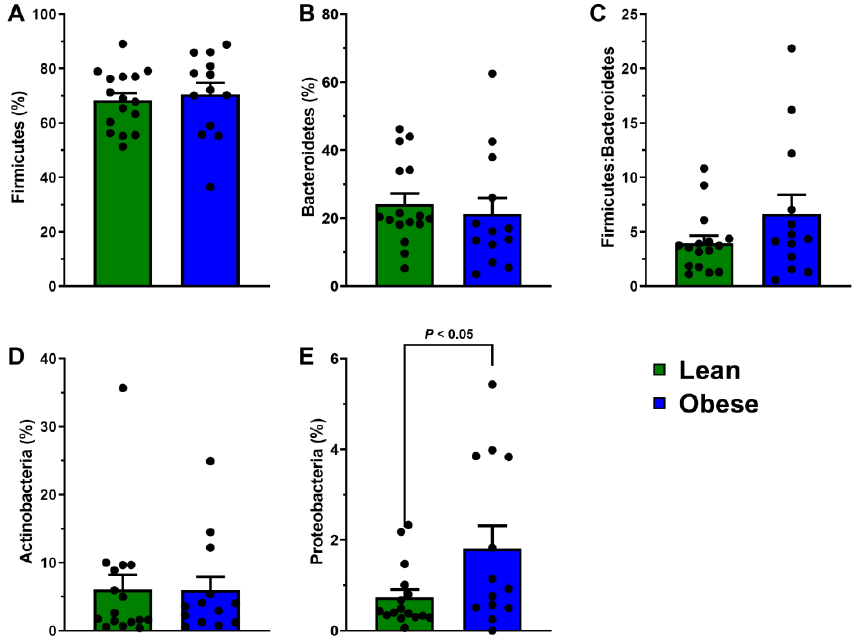
Figure 4. Phyla-level abundances of gut microbiota in obese and lean individuals. ( A ) Firmicutes, ( B ) Bacteroidetes, ( C ) Firmicutes:Bacteroidetes ratio, ( D ) Actinobacteria, and ( E ) Proteobacteria between obese and lean individuals. Data (means ± SEM, n = 13 to 16 per group) were analyzed using QIIME2 (version 2019.10).